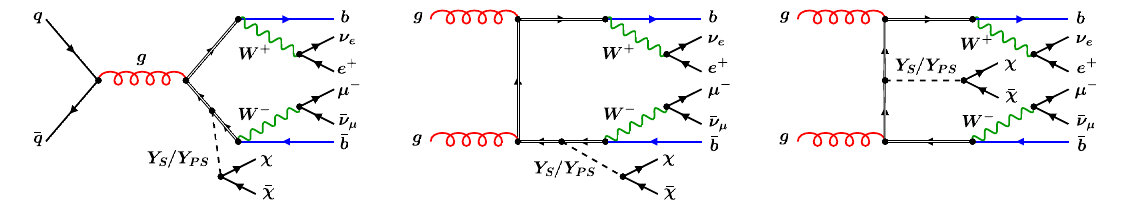
Fig. 2 Leading order Feynman diagrams for the DM particle pair production via a scalar Y S or a pseudoscalar Y PS mediator in association with a top-quark